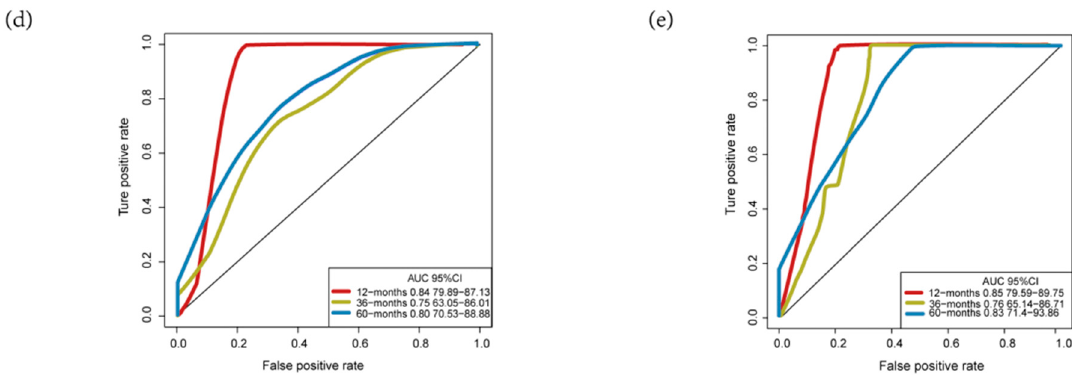
Figure 6. Assessment of four-MDELs HCC signature prognostic risk score model. The patients were stratified into high risk group and low risk group based on median of risk score. ( a ) Risk score distribution of HCC patients, Survival status of each patient and Expression heatmap of the four-MDELs corresponding to each sample above. Red: high expression and risk; Blue: low expression and risk; ( b , c ) Kaplan-Meier estimates of the OS time of the patients in the training set and the validation set using the four-MDELs signature-based risk score; ( d , e ) The ROC curve of the training set and validation set for 1-,3- and 5-year survival prediction.